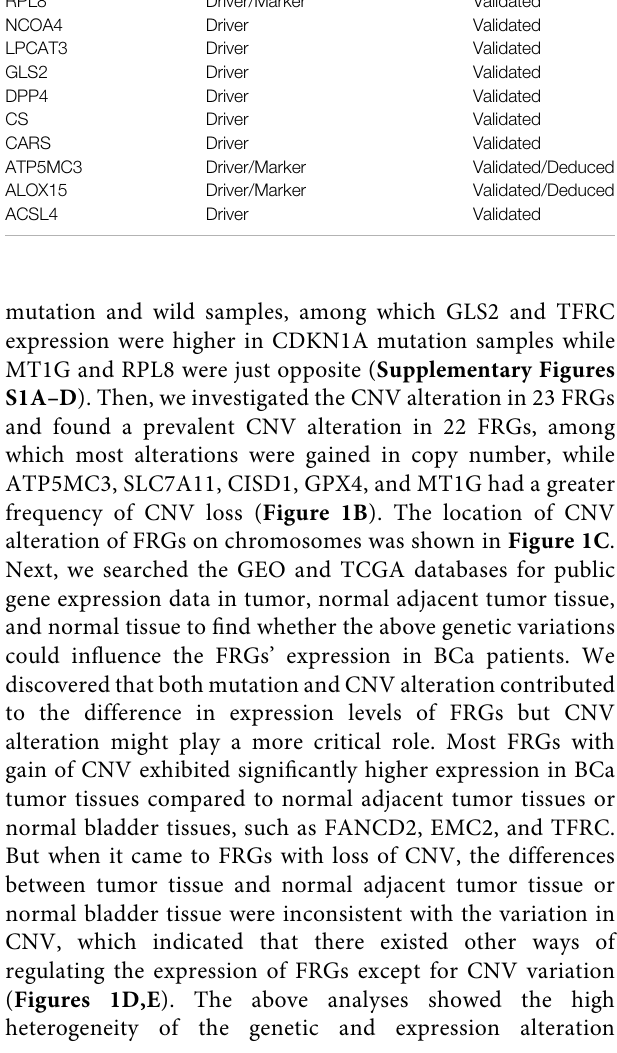
FIGURE 1 | column represented individual samples. The upper line represented the type of tissues. The color of each pane represented the expression level. (E) Expression of 19 ferroptosis regulator genes between normal bladder tissues, normal adjacent tumor tissues and tumor tissues in GSE13507 cohort. Tumor, blue; Normaladjacenttumor,green;Normal,red.Theupperand lowerends oftheboxesrepresented interquartilerangeofvalues.Thelinesintheboxesrepresented median value, and black dots showed outliers. The asterisks represented the statistical p value (* p < 0.05; ** p < 0.01; *** p < 0.001).